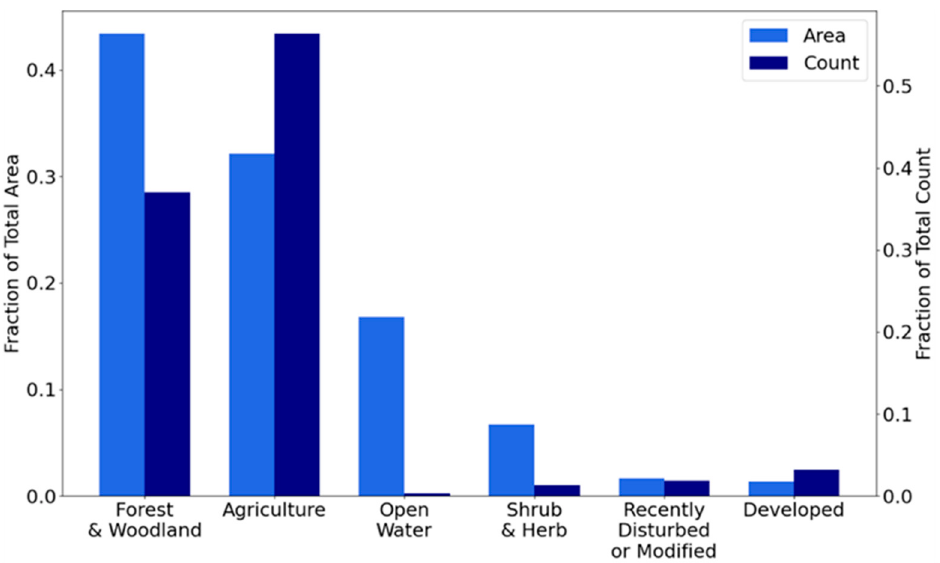
Figure 16. General land-use and land-cover type of Carolina Bay detections by fraction of total area and fraction of total count.